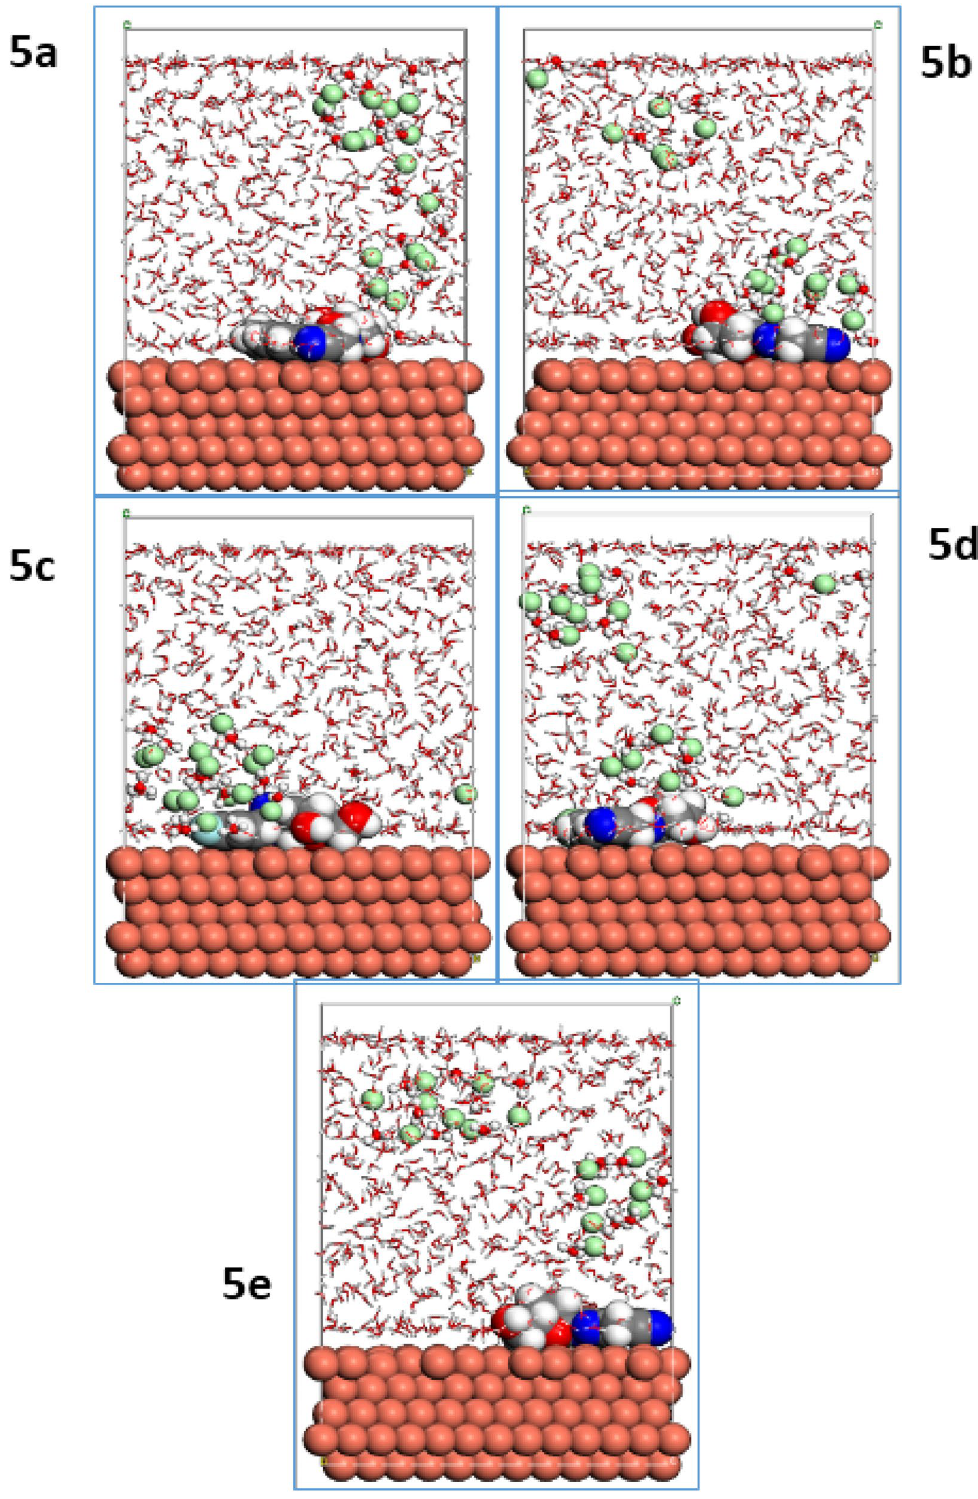
Figure 11. Lowest energy MD side view of 5a – e onto Cu(111)